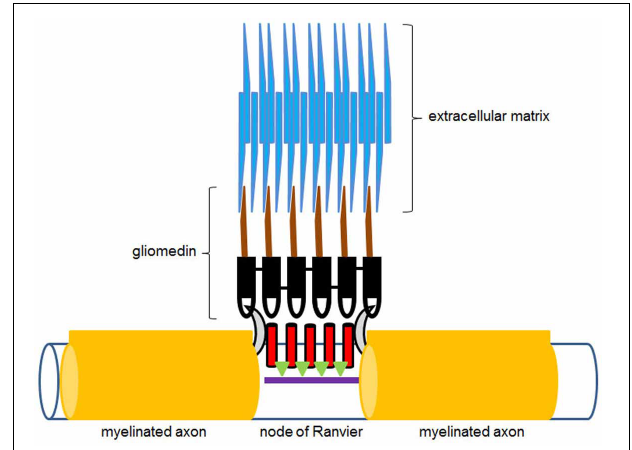
FIGURE 4 | Diagrammatic illustration of the hypothetical action of gliomedin at the nodes of Ranvier. The olfactomedin domain of gliomedin, shown in black, interacts with neurofascin (gray half-moon shapes), while the collagen domain containing region of the molecule, shown in brown, is integrated in the extracellular matrix (blue). Voltage-dependent sodium channels at the nodes of Ranvier are shown in red. Green triangles represent ankyrin G, which links the channel proteins to β IV spectrin (purple), which is part of the axonal cytoskeleton underneath the nodes of Ranvier. See also Eshed et al.